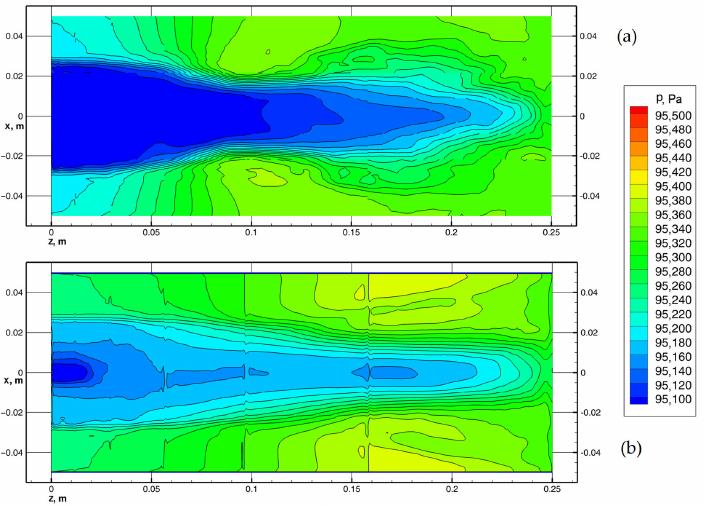
Figure 5. Averaged pressure fields before the bottleneck breakup, 14–17 ms ( a ), and after the breakup, 20–40 ms ( b ). Hereinafter, all the provided results will refer to the flow structure observed before the bottleneck breakup, namely between 13 and 19 ms. Time averaging was applied from 14 to 17 ms. During the averaging period, azimuthally ‐ averaged instant temperature fields were found to be stable. 3. Results and Discussion In this section, the time ‐ and azimuthally ‐ averaged data will be compared with ex ‐ perimental measurements and other authors’ simulations. As stated by Hu, Zhou, and Luo [21], different turbulent combustion models predict different positions of the bottle ‐ neck. The second ‐ order moment model (SOM) tends to develop bottleneck upstream from its experimental position, while the PDF ‐ based flamelet approach shifts the bottleneck downstream. Time and azimuthally ‐ averaged axial velocity comparison between the Smagorinsky and DSM models with PDF flamelets shown in Figure 6 revealed a weak influence of the subgrid ‐ scale model on the bottleneck effect. However, the subgrid model has a signifi ‐ cant impact on the central fuel jet and its penetration length, as shown in the 20 and 70 mm sections. The mixing of the central jet with surrounding gas is too slow in the Sma ‐ gorinsky model simulation, whereas the DSM model gives a more adequate mixing rate, which is consistent with experimental measurements. Comparison of the distant sections (100 and 120 mm) revealed that the presented simulations are closer to the experiment near the axis compared to the Hu, Zhou, and Luo profiles. This may be the result of a different numerical scheme and a different turbulence ‐ combustion interaction model, as well as the reaction rate limitation for premixed zones (13). The main discrepancy in the velocity field is observed in the surrounding flow. This flow is too fast in the present simulation due to the acceleration produced by the imperfect value of the pressure specified at the outlet.